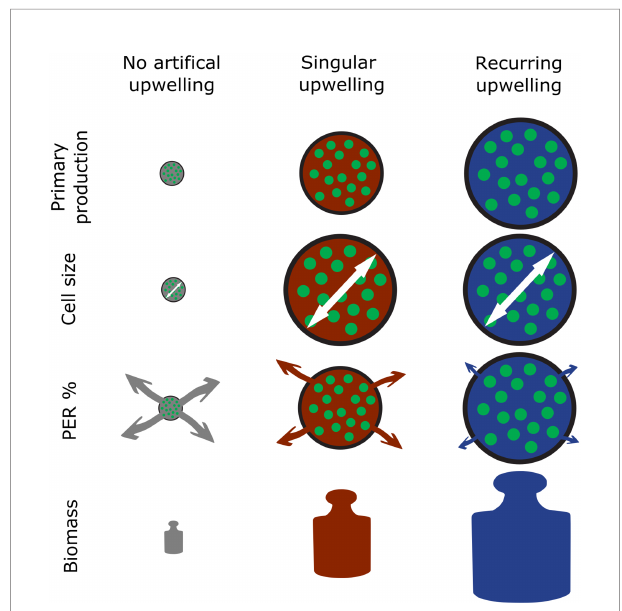
FIGURE 7 | Schematic depiction of the main fi ndings surrounding primary production in this study. PER, Percentage Extracellular Release. The white arrows illustrate cell size and arrows under PER% the magnitude of extracellular release.